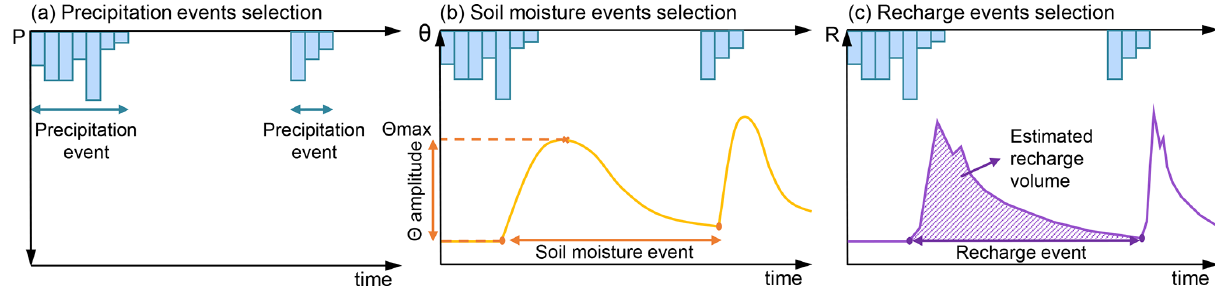
Figure 1. Event selection method applied in this study exemplified for two precipitation (a) , soil moisture (b) and recharge (c) events.